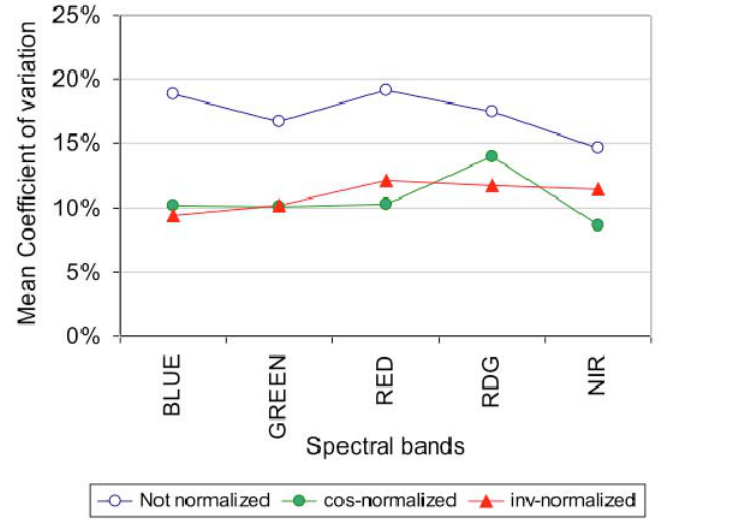
artificial invariant targets: no normalization, cosine and invariant methods. The mean coefficient of variation (CV) is the average of CV of the four artificial targets’ digital numbers measured over the acquisition period.